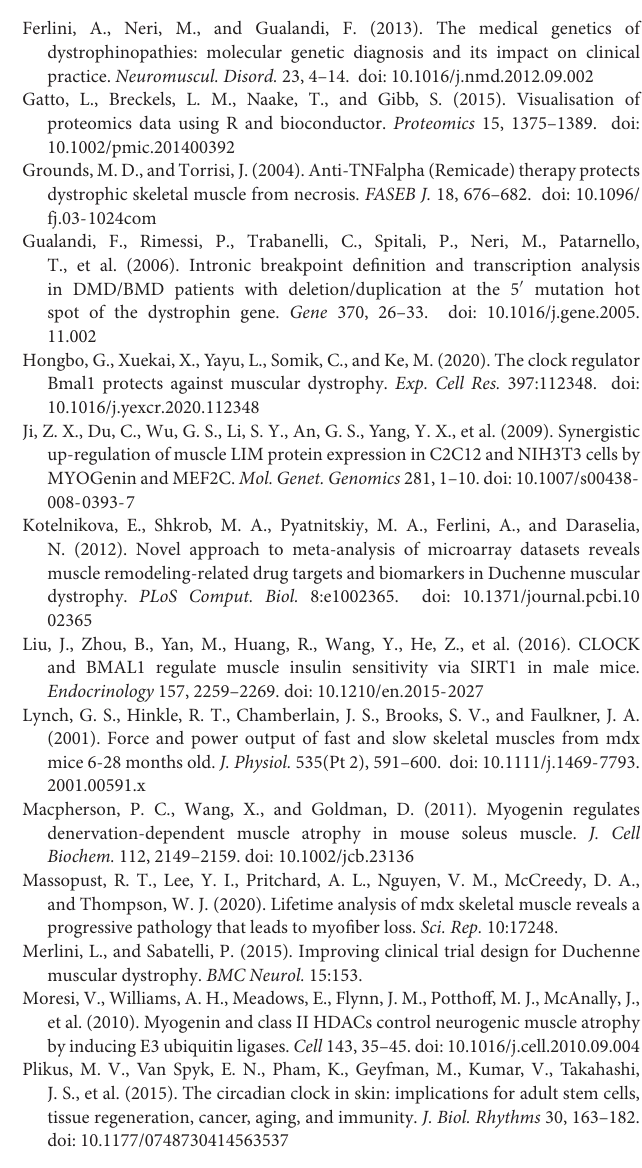
circadian rhythm, muscle regeneration, metabolism, apoptosis, immune reaction, and cellular proliferation, plus ACTIN-B and GAPDH as reference genes. Supplementary Figure 2 | Fluid-CIRC expression data of Gastrocnemius GC (A) , and Tibialis anterior TA (B) of WT (blue bars), mdx sedentary (red bars) and mdx exercised (green bars) samples. Mean standard error (SEM) is indicated with error bars. In mdx CCGs are deregulated with a trend through a general downregulation. Genes with a statistically significant variation ( p -Value < 0.05) are indicated with asterisk ( ∗ ). Only MYOG is consistently upregulated in both muscle types. Comparing mdx-sedentary vs. mdx-exercised, we can observe an opposite behavior of the two selected muscle types. MYOG and MYOD don’t show a consistent change of expression with respect to mdx. Supplementary Figure 3 | Csnk1 ε protein plasma levels in DMD patients analyzed with respect to phenotype (A) , mutation type (B) , and age (C) . White bars are averaged controls (protein concentrations measured in the 6 controls were averaged and used for the comparison), gray bars are BMD patients ( n = 2) and black bars are DMD patients ( n =